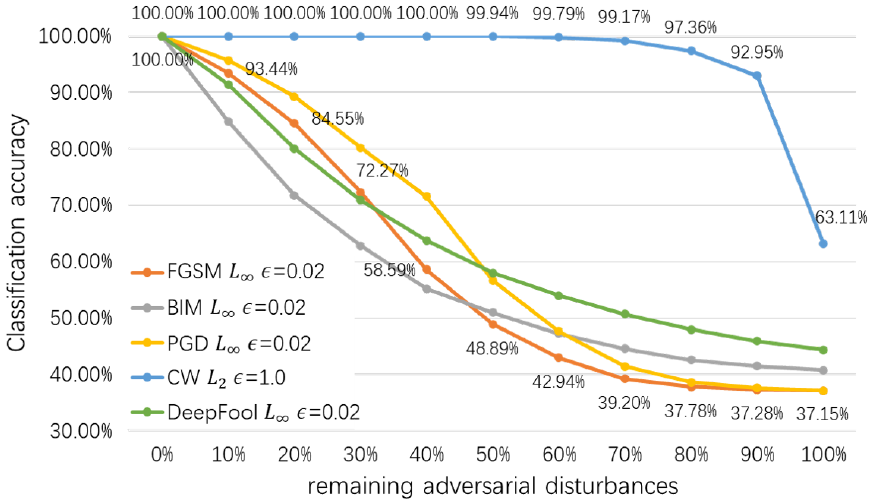
Figure 3. An experiment showing weakened effect of partially removed adversarial vectors generated from CIFAR-10 samples on the accuracy of a VGG16 network.